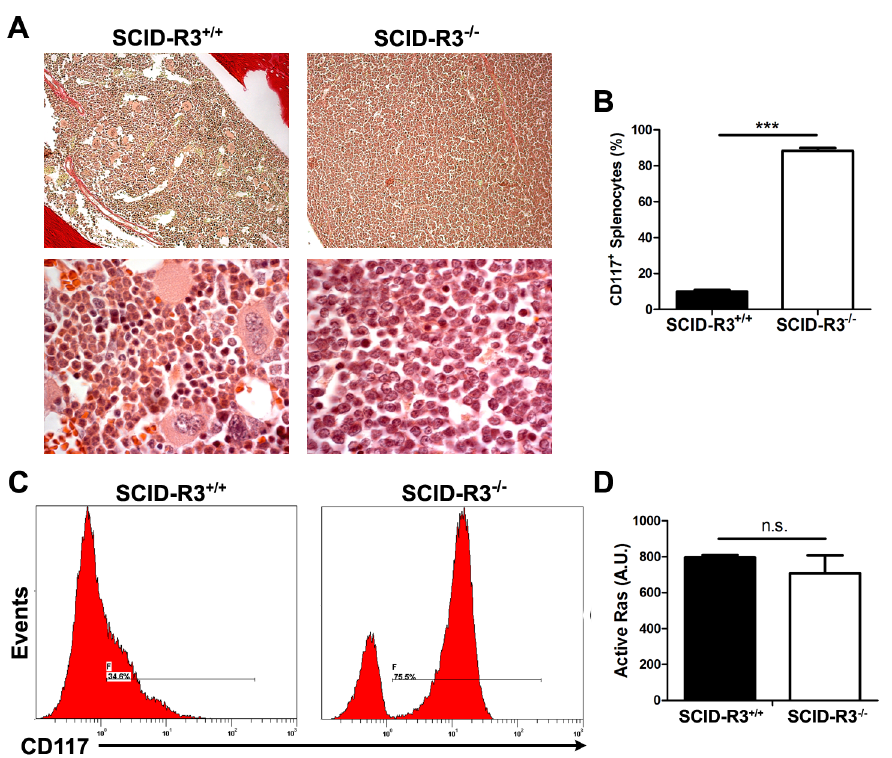
Figure 7. SCID-Rasa3 2 / 2 mice develop a CD117 + CD38 + Sca-1 + cell preleukemia. A. Representative images of a hematoxylin/eosin-stained section of a femur from a SCID-Rasa3 + / + mouse and one of the four SCID-Rasa3 2 / 2 mice with a homogeneous cellular infiltration of the bone marrow and the spleen (upper panels: magnification: 6 20; lower panels: magnification: 6 100). B . CD117 + splenocyte percentages in SCID-Rasa3 + / + (n=10) and in the four SCID-Rasa3 2 / 2 mice with a preleukemia. Statistics (unpaired t test): ***: P , 0.001. C . Representative flow cytometry analysis of bone marrow cells from a SCID-Rasa3 + / + mouse (left histogram) and one of the four SCID-Rasa3 2 / 2 (right histogram) mice with a preleukemia, using a CD117 antibody. The histograms show the CD117 fluorescence intensity and the relative number of cells (events). D . Fetal liver cells from Rasa3 + / + and Rasa3 2 / 2 E12.5 embryos were stained with a CD117 antibody and analyzed for active GTP-bound Ras level by immunofluorescence using GST- Raf1-RBD and a FITC-conjugated mAb against GST. The graph represents the intensity of active GTP-bound Ras staining, expressed in arbitrary units (A. U.), in Rasa3 + / + and Rasa3 2 / 2 CD117 + HSC. Mean 6 SEM are presented.